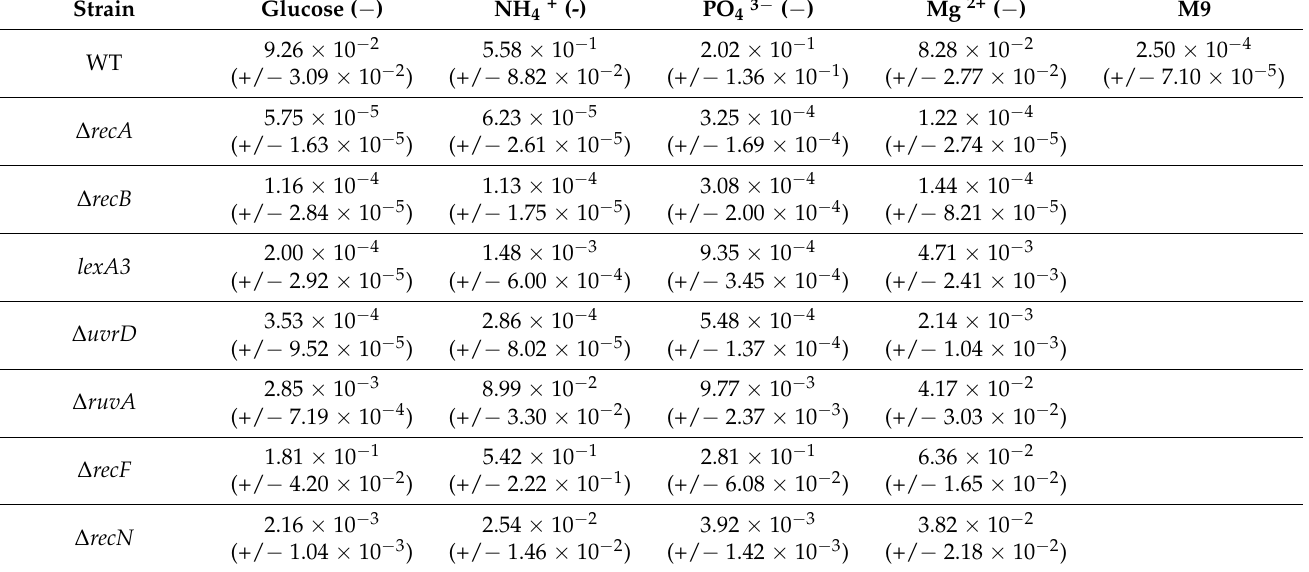
Table 1. Survival fractions after 5 h of treatment with LEVO *.